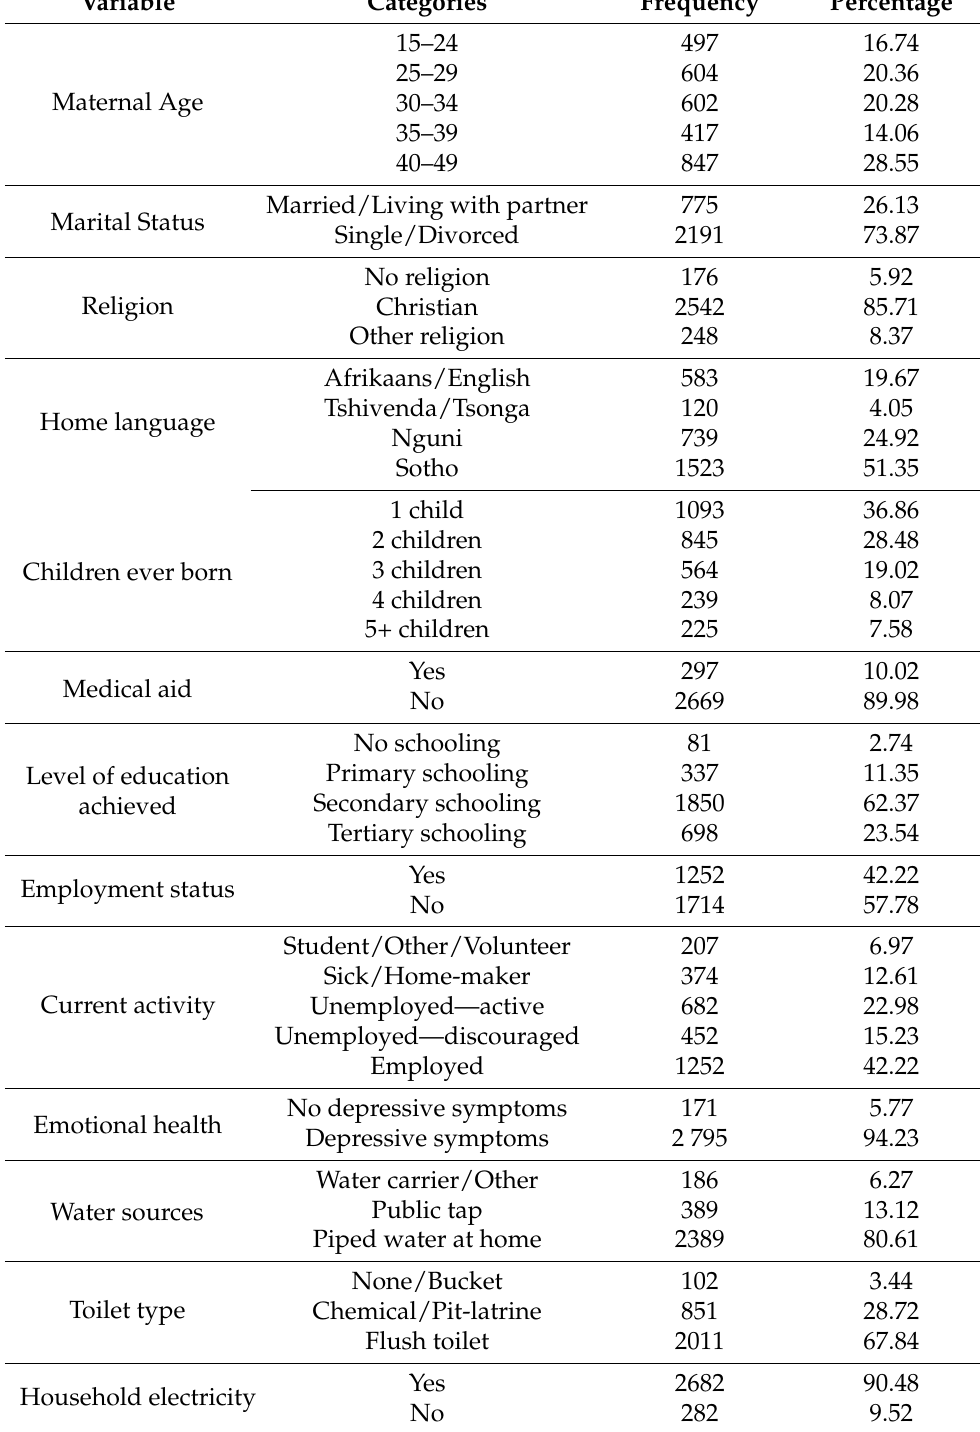
Table 1. Sociodemographic characteristics of mothers of children under five (N =